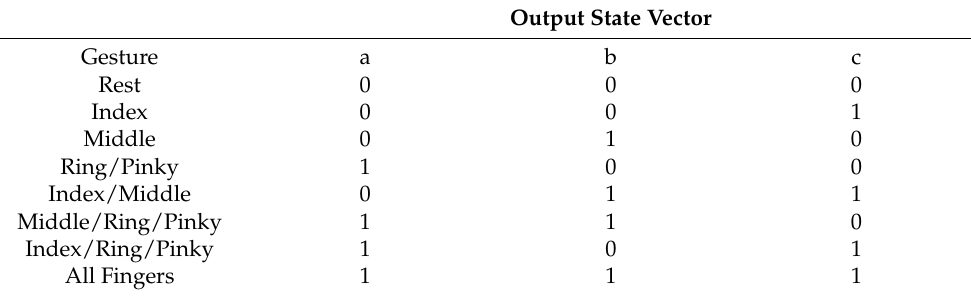
Table 1. Outputs state vector mapping of the classified